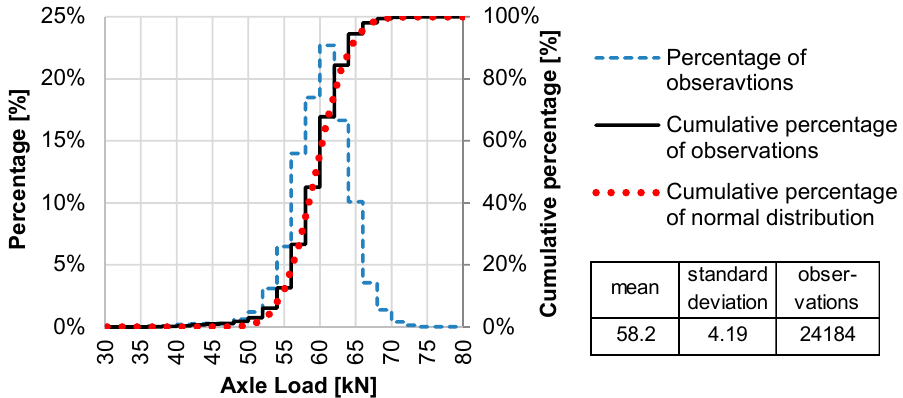
Figure 4. Example of steering axle load spectrum (SALS) determined for WIM station no. 58.